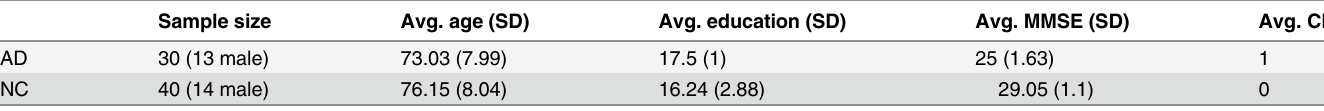
Table 1. Participant demographics. Sample